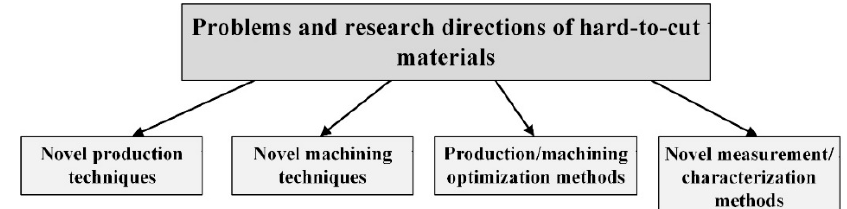
Figure 1. Current major problems and directions concerning the hard–to–cut materials.